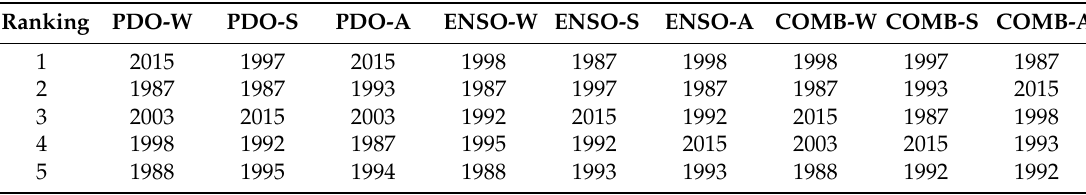
Table 6. Ranking of the mean Pacific Decadal Oscillation Index (PDO), El Niño/Southern Oscillation (ENSO), and PDO–ENSO for 1984–2015, for summer (S), winter (W), and annual (A). Ranking PDO-W